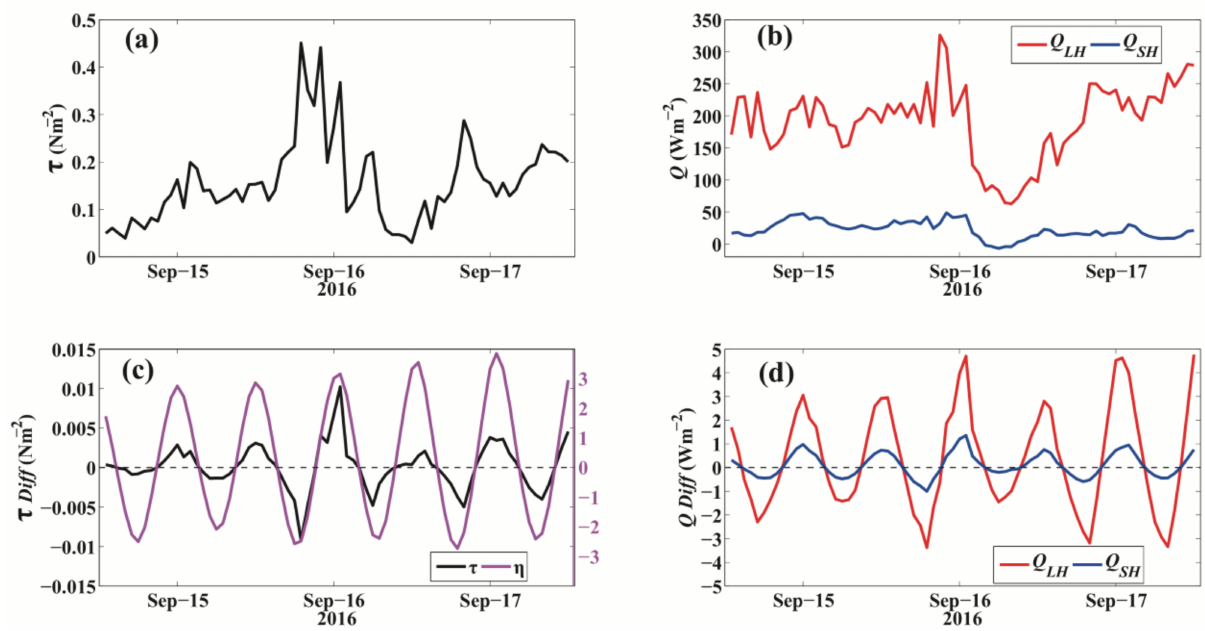
Figure 14. The wind stress (Nm − 2 , ( a )) and turbulent heat fluxes (Wm − 2 , ( b )) during TC Meranti from 15 to 17 September 2016. ( c ): Wind stress differences (left y-axis) with variations in the magnitude of SSE (magenta, right y-axis) during TC Meranti. ( d ) is the same as ( c ) but for Q LH (red, unit: Wm − 2 ) and Q SH (blue, unit: Wm − 2